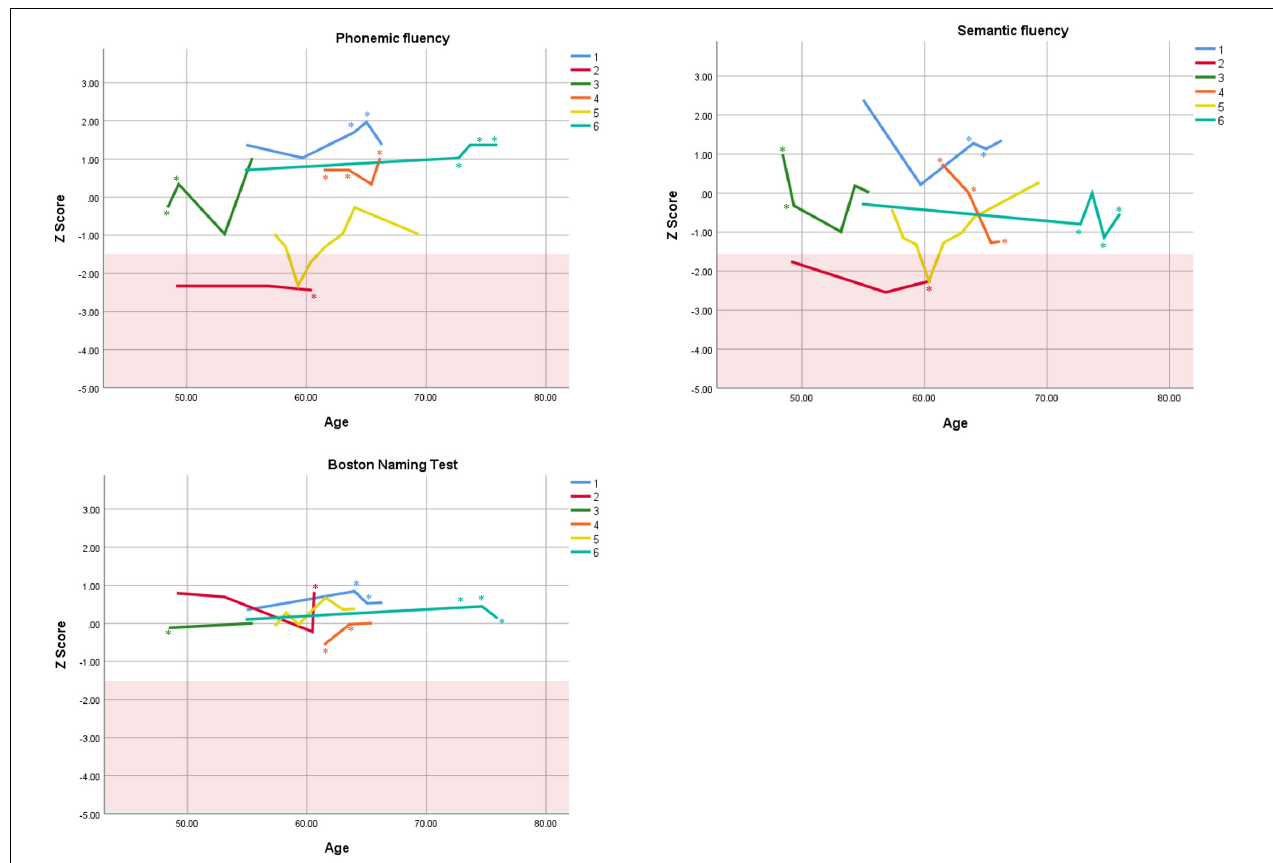
FIGURE 4 | Individual longitudinal performance on measures of language. Shaded red area represents impaired performance ( Z < –1.5). *Denotes clinically significant depressive symptoms at that visit (30-item GDS ≥ 10 or BDI-II ≥